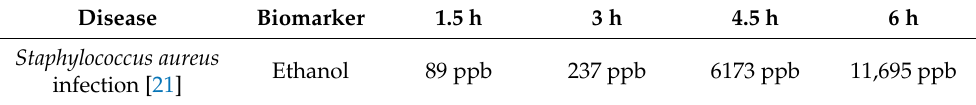
Table 2. Evolution of ethanol concentration in Staphylococcus aureus cell culture over